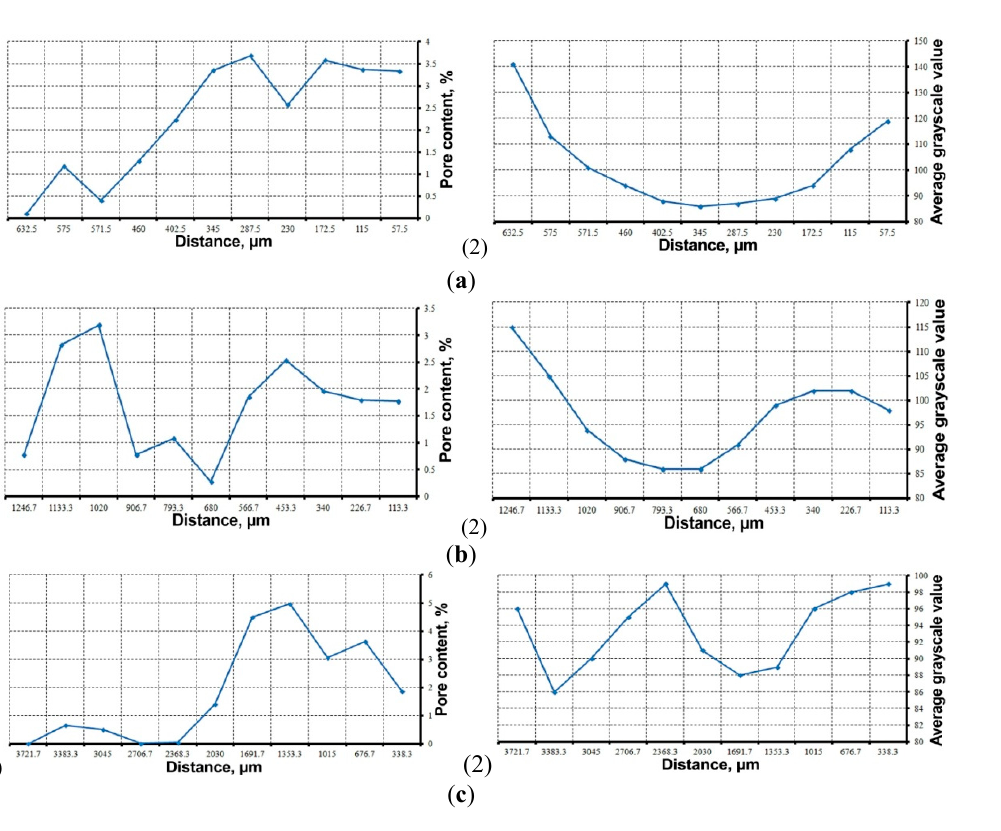
Figure 9. Change in porosity ( 1 ) and average grayscale value ( 2 ) along the scan direction: ( a ) frontal, ( b ) profile, ( c ) vertical.